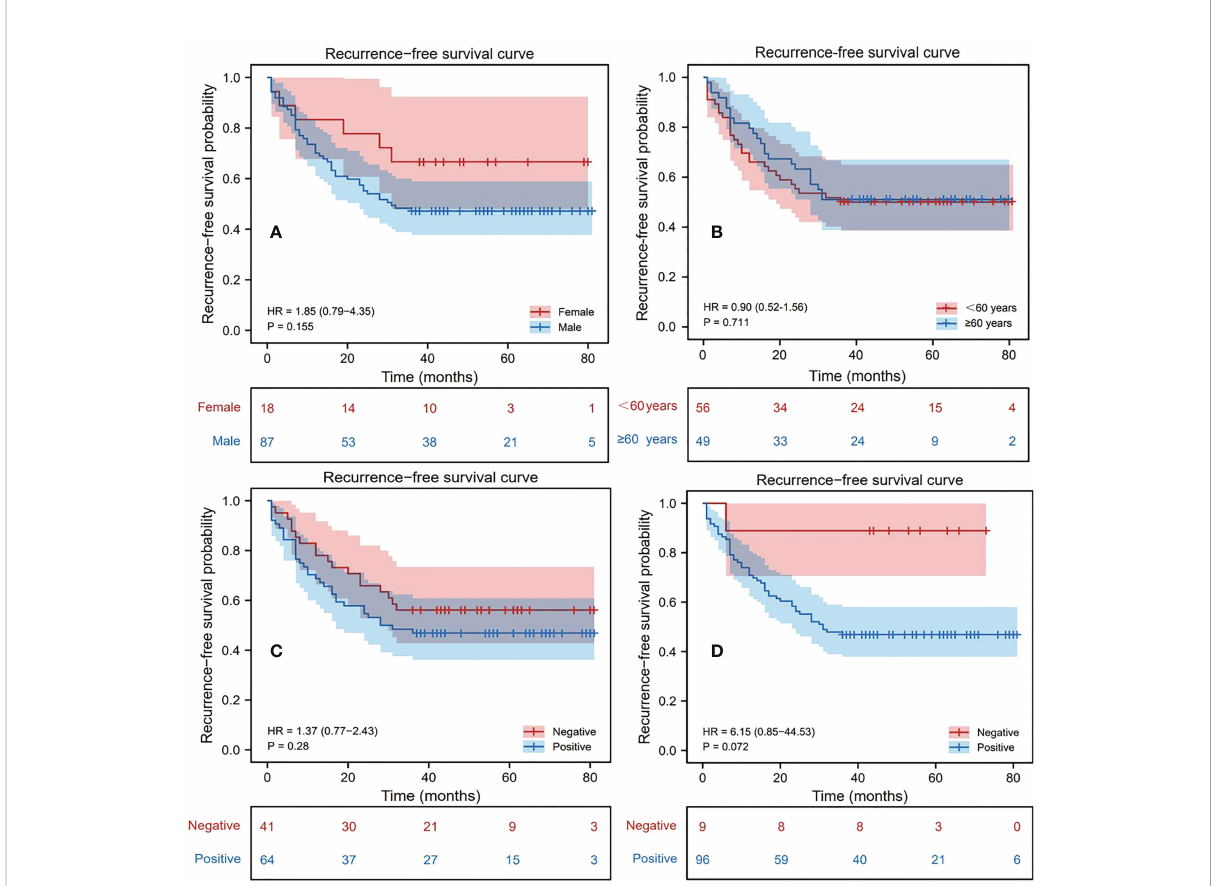
FIGURE 2 Kaplan-Meier survival analysis curve of patients, where the variables in (A – D) are gender, age, alpha-fetoprotein (AFP), hepatitis B surface antigen (HBsAg)